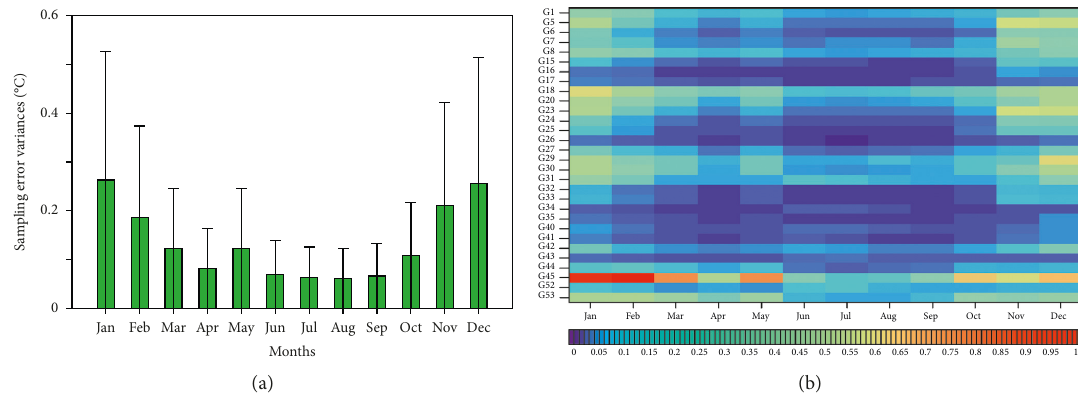
Figure 4: (a) Climatological mean (1979–2012) of monthly sampling error variances averaged for all grid boxes; (b) monthly mean variations in sampling error variances for each grid box from 1979 to